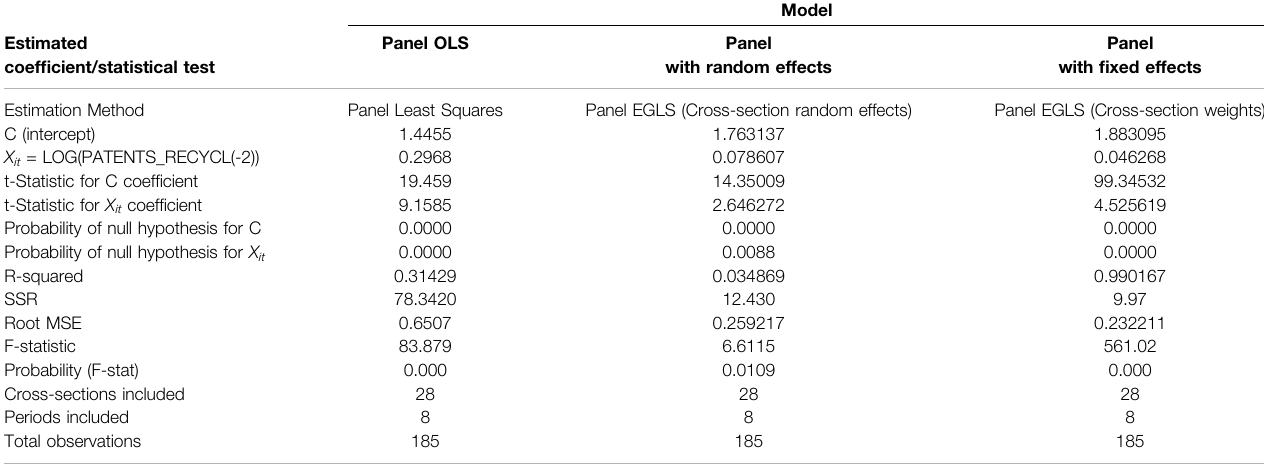
TABLE 4 | The estimated coef fi cients and statistical tests of the econometric models taken into consideration.